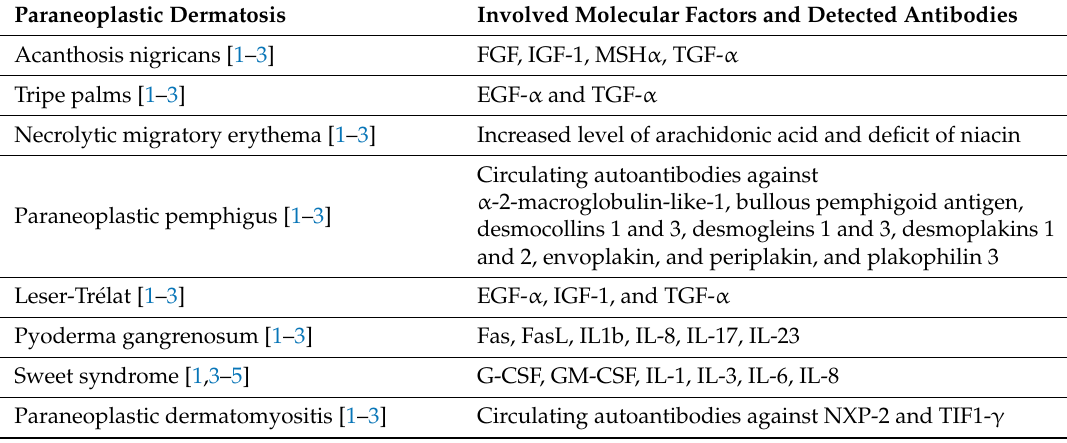
Figure 2. Sweet syndrome. Facultative paraneoplastic dermatosis characterized by multiple painful, sharply circumscribed dark red edematous nodules. It is usually associated with myeloproliferative and lymphoproliferative disorders. Table 2. Molecular findings in paraneoplastic dermatoses.